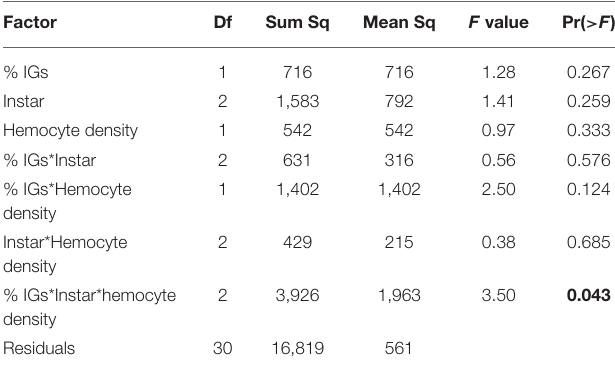
TABLE 4 | For caterpillars reared on Plantago in September, ANCOVA revealed a three-way interaction between percent dry weight total IGs sequestered, hemocyte density, and caterpillar instar on melanization.